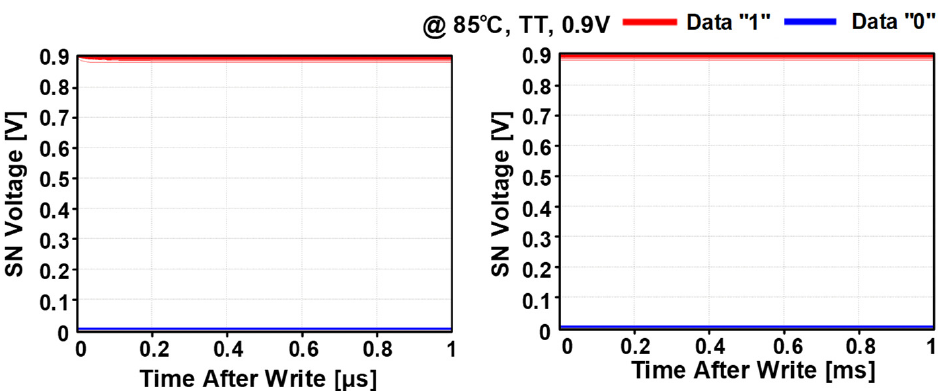
Figure 8. Monte Carlo mismatch simulation of data retention after storing data “0” and “1”.